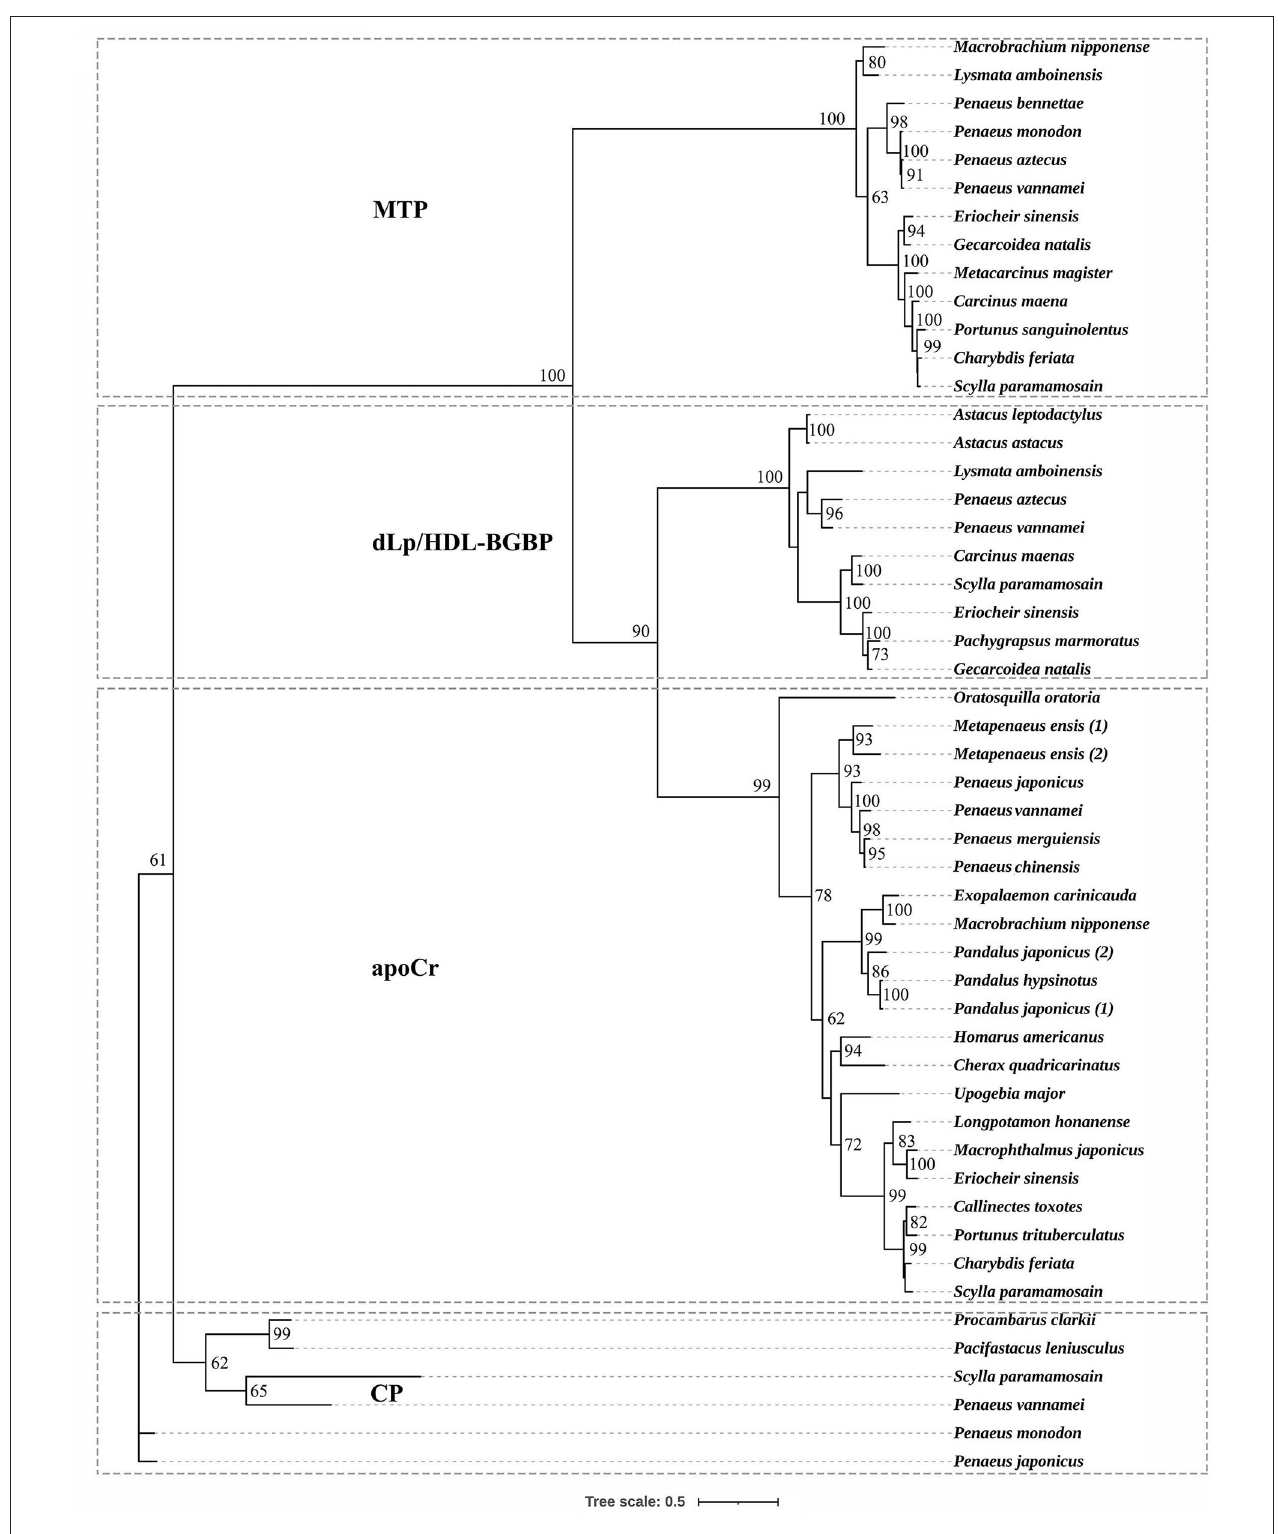
FIGURE 1 | Phylogenetic tree of large lipid transfer proteins in decapodan species, using the maximum likelihood method. The tree topology was based on the alignment of the conserved amino acid sequence of the LPD_N domain. The numbers at each node indicate bootstrap values and bootstrap values < 50 are not provided. apoCr, apolipocrustacein; CP, clotting protein; dLp/HDL-BGBP, precursor of discoidal lipoprotein and beta-1,3-glucan binding protein; MTP, microsomal triglyceride transfer protein. Detailed information of LLTPs is listed in the Supplementary Table .